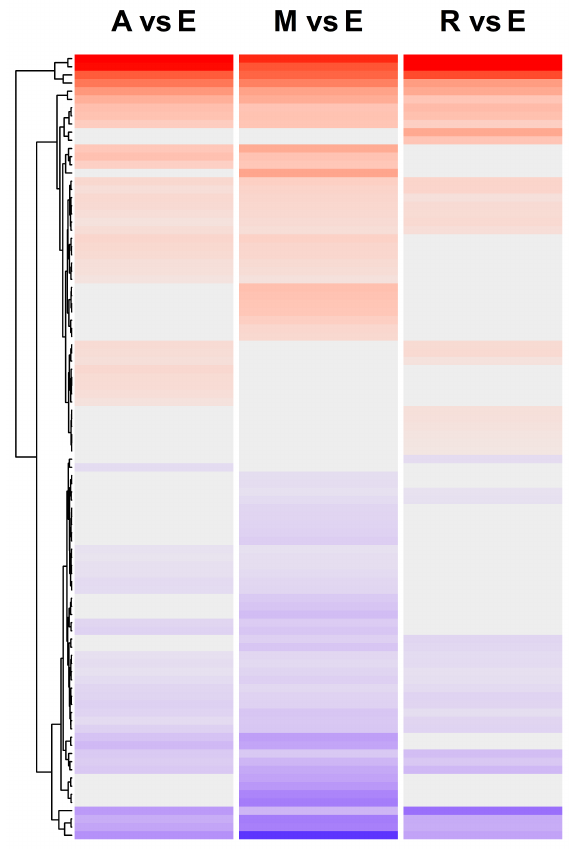
Figure 7. Comparisons between C. echinospermum and C. reticulatum and between C. echinospermum and cultivated Cicer share the same direction of expression regulation. The heatmap displays FC values for the comparisons of C. arietinum (A), the ICCV 96029 mutant (M), and C. reticulatum (R) with C. echinospermum (E) in the early flower buds. It is evident that the color in each row (corresponding to an individual gene) does not change between the columns (corresponding to each of the comparisons). Up- and downregulation arw shown in red and blue, respectively. Gray cells correspond to an absence of differential expression between species/accessions. In the entire dataset, only two outliers were found, Ca_26523 (PRMT10) and Ca_01826 (PRMT5a) , both in the leaves AF (Figure